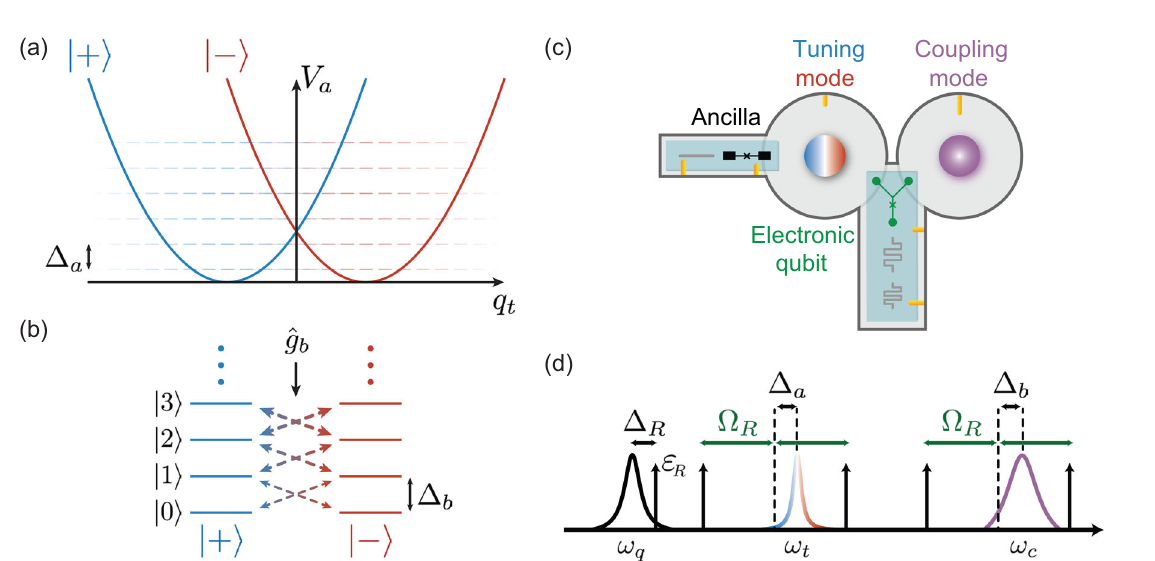
ˆ H FIG. 1. Model molecular Hamiltonian with a conical intersection and experimental setup. (a) Eigenspectrum of , which consists of a two displaced quantum harmonic oscillator Fock ladders (dashed lines) of the tuning mode depending on if the qubit is in jþi (blue) or ˆ ˆ b þ b † Þ on top of ˆ H couples the two Fock ladders of the j − i (red). (b) In the basis of j(cid:2)i for the qubit, the addition of ˆ g b ¼ g y ˆ σ y ð a ˆ ˆ − j þ j − ihþj (dashed arrows) for each Fock state of the tuning mode. Hence, b † b ) via ˆ σ coupling mode (with energy Δ b y ¼ jþih dynamics of the coupling mode can cause transitions between j(cid:2)i . (c) Schematic of the circuit QED device used in this experiment. The tuning and coupling modes are 3D λ = 4 coaxial resonators which are coupled to an electronic qubit (encoded in a transmon) with a readout resonator and Purcell filter [31]. An additional ancilla module with a transmon mode and readout resonator is coupled to the tuning mode for independent state tomography. The coupling mode is intentionally overcoupled to a 50 Ω transmission line, resulting in = 2 π ≈ 320 kHz. (d) Relative mode frequencies and drive configuration used to enact ˆ H a linewidth κ . A full table of system b LVC parameters is given in Appendix